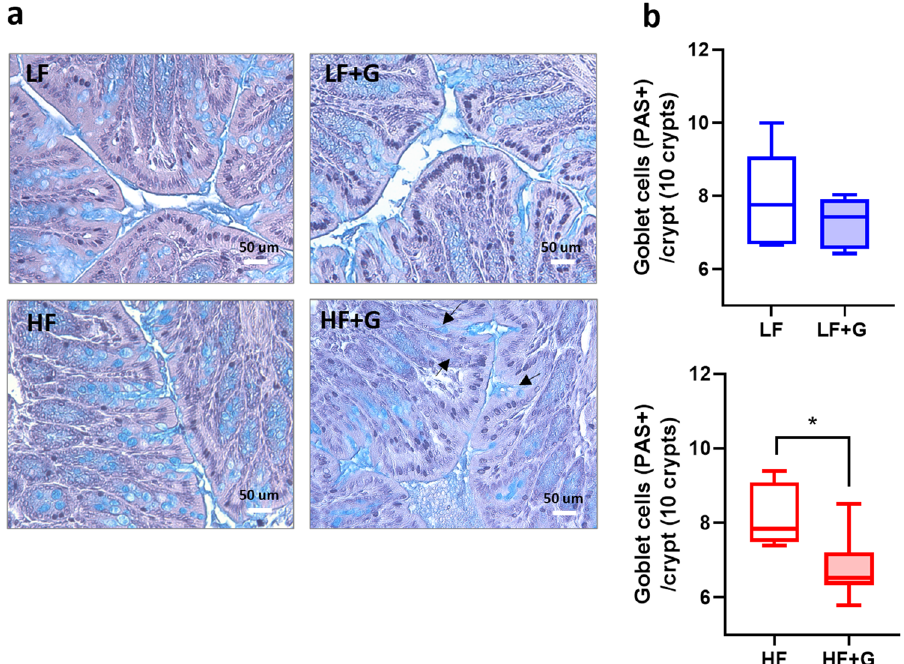
Figure 7. High fat exacerbates Giardia -induced depletion of colonic goblet cells. ( a ) Alcian Blue/PAS staining of distal colon sections of control (LF and HF) and infected (LF + G and HF + G) C57BL/6 mice. Goblet cells are stained in light blue. Scale bar = 50 μm. ( b ) Total goblet cell count (PAS +) per crypt. Blind histological examination 10 crypts of jejunum. Surface area was quantified using ImageJ software. Arrows indicate colonic goblet cells depletion. n = 8–9 per group. Data are expressed as box plots with min/max whiskers; * p <